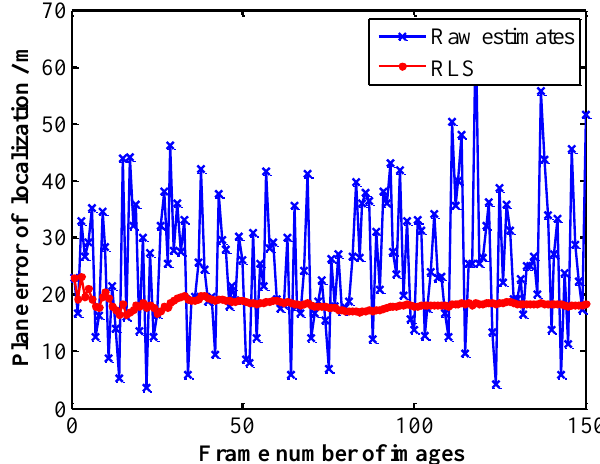
Figure 14. Plane localization errors after RLS filtering.